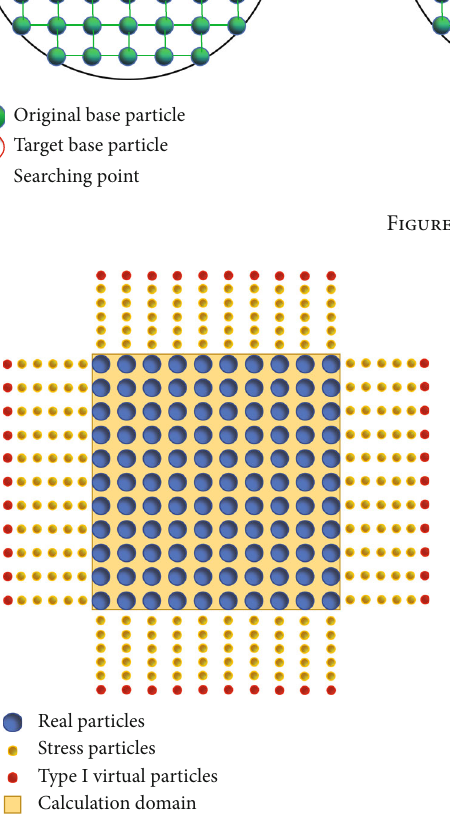
Figure 5: Stress boundaries.